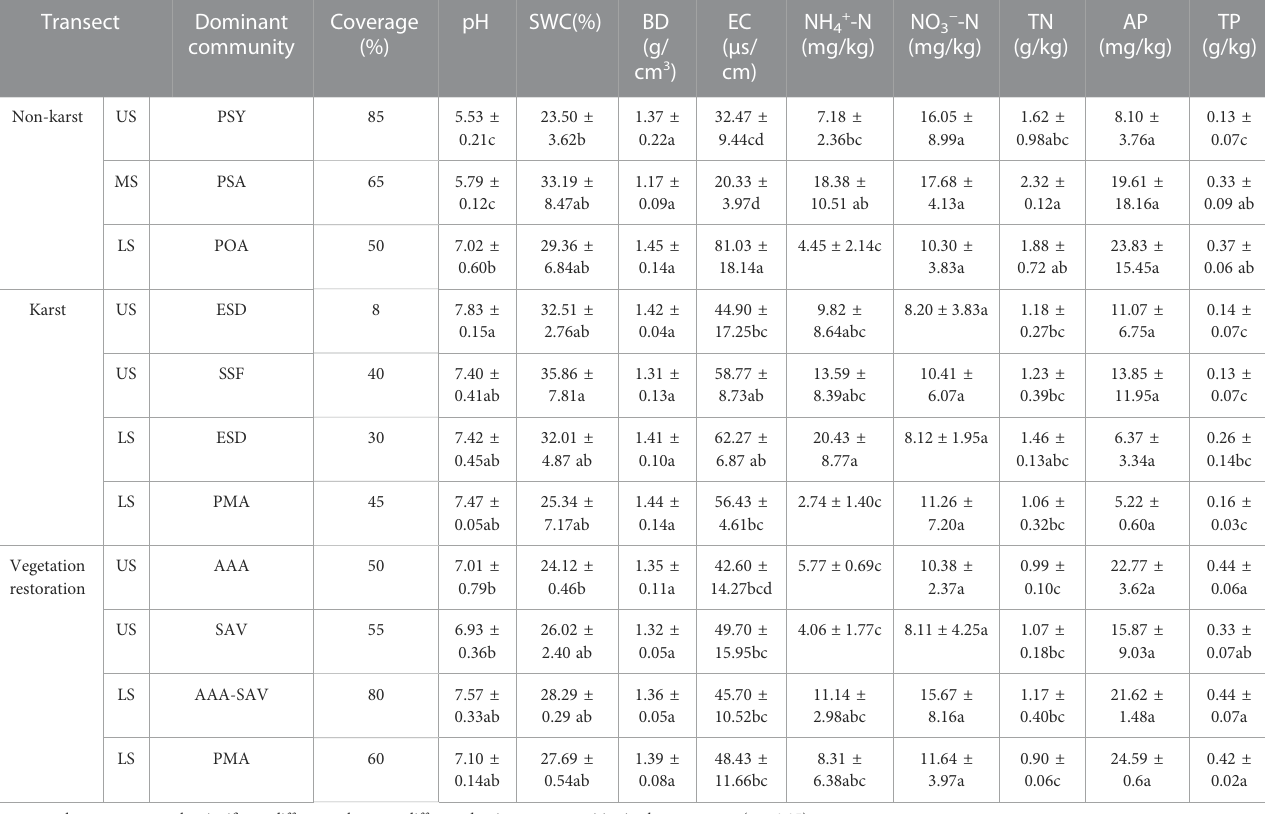
TABLE 2 Physical and chemical properties of surface soil from the different transect. Transect